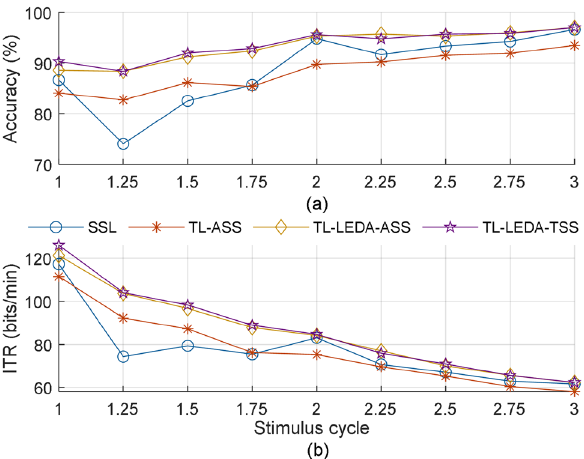
Figure 5. Relationship between the averaged accuracy ( a ) and ITR ( b ) of the four algorithms (SSL, TL-ASS, TL-LEDA-ASS and TL-LEDA-TSS) across subjects and the data length used for target recognition. The data length is denoted as the multiple of the stimulus cycle.